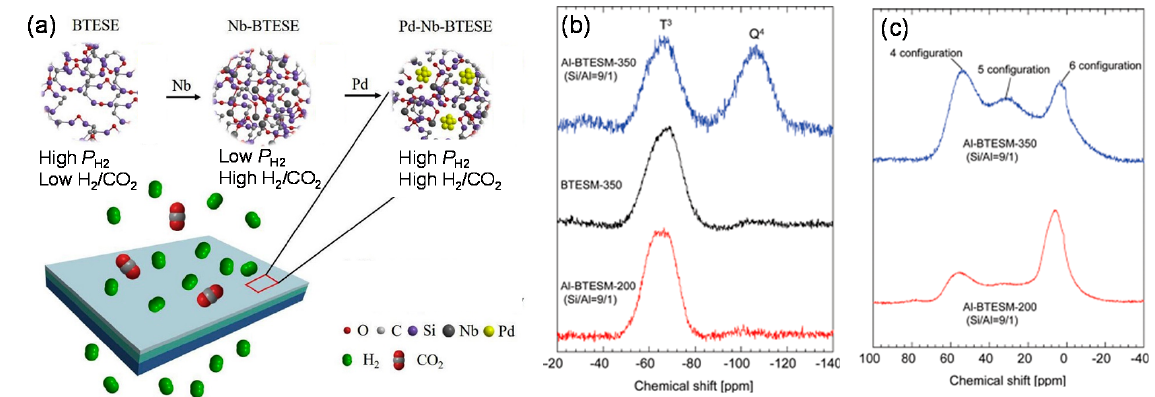
Figure 13. ( a ) Schematic image of the possible structures of Pd–Nb–BTESE networks for H 2 /CO 2 separation [114]. ( b ) 29 Si and ( c ) 27 Al magic-angle spinning nuclear magnetic resonance (MAS NMR) spectra for BTESM and Al-BTESM gel powders [100].